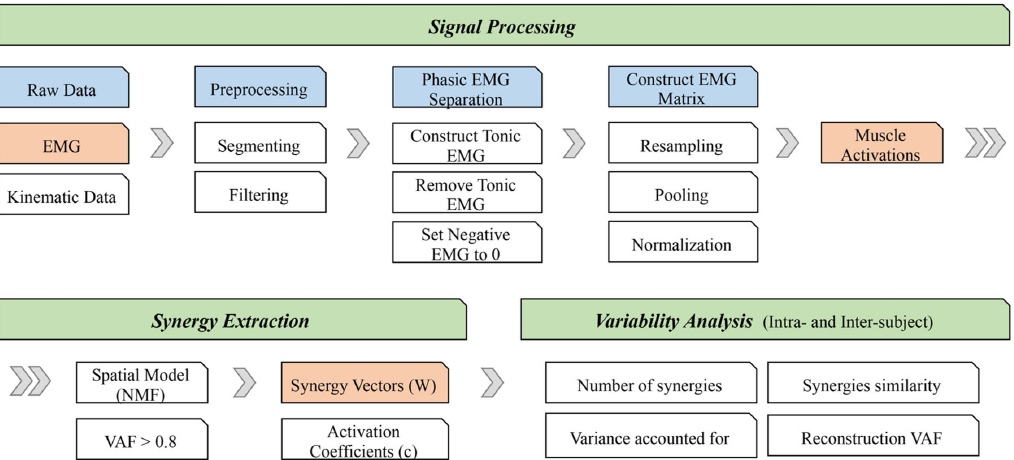
Figure 2. Data analysis flowchart.